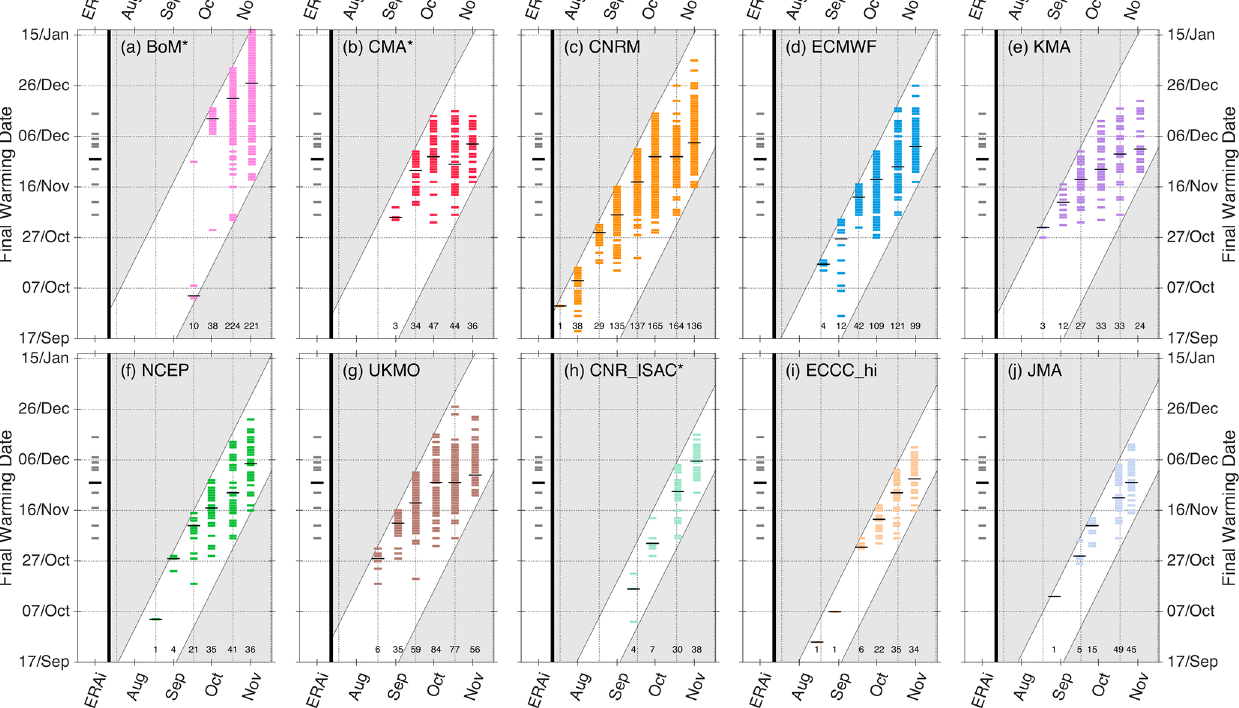
Figure 11. Plots showing the distribution of Southern Hemisphere final warming dates predicted by each S2S system. The reanalysis final warming dates from ERA-I (ERAi in the figure) are shown by the grey strips on the left side of each panel. The systems are composited based on initializations that fall closest to the beginning or middle of each month as specified on the x axis. The diagonal white region represents the approximate maximum forecast horizon for each system and